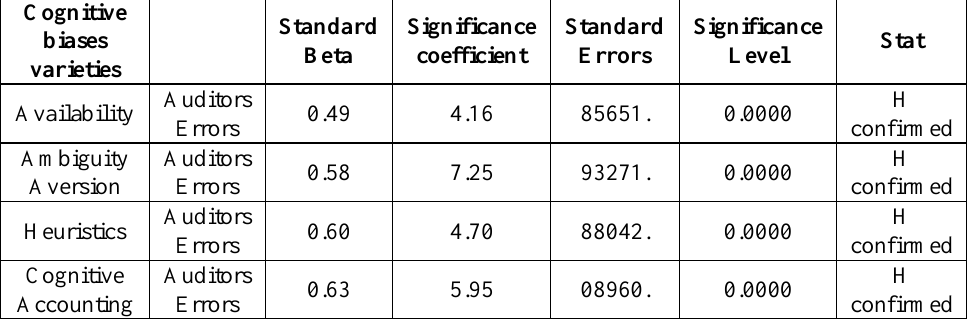
Table (1) Bias role analysis test on auditors’ errors based on standard